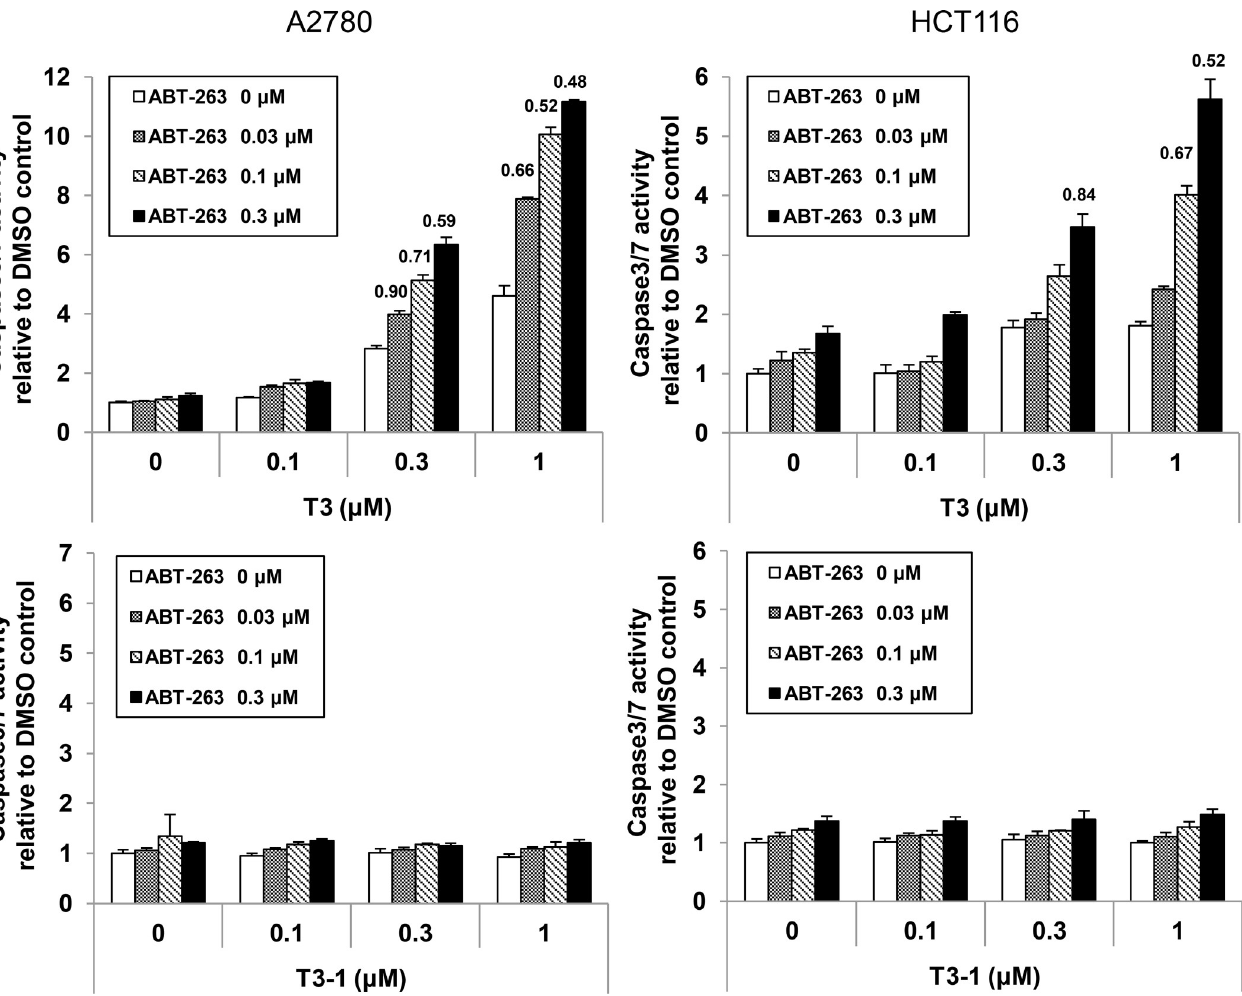
Fig 6. Synergistic effects on apoptosis induction were observed by T3 in combination with Bcl-2 inhibitor in HCT116 and A2780 cells. HCT116 and A2780 cells were treated with T3 or T3-1 and ABT-263 at the indicated concentrations for 16 h or 24 h, respectively. Caspase 3/7 activities were measured. Combination index (CI) values [24] are shown above the bar. A CI value of < 1 indicates synergism. Data are presented as the mean ± SD of two independent experiments.